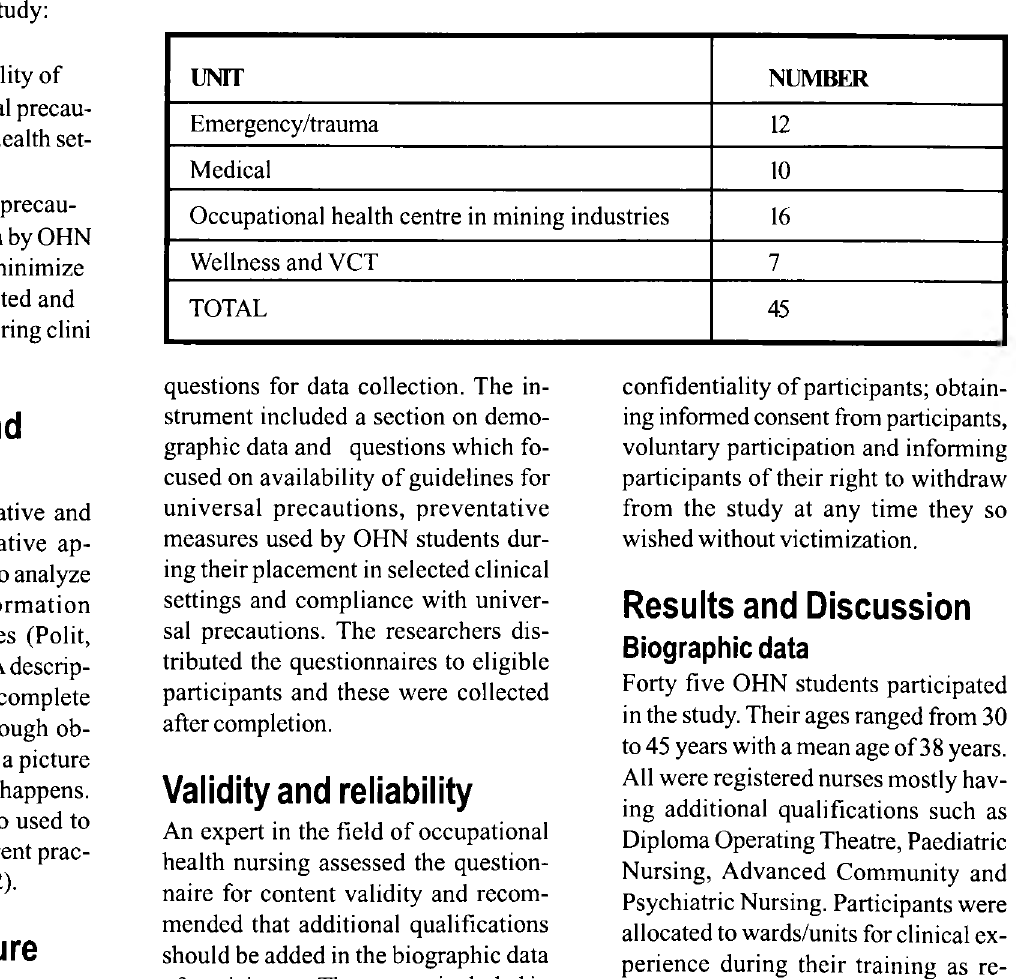
Table 1: Units where OHN students were placed for clinical